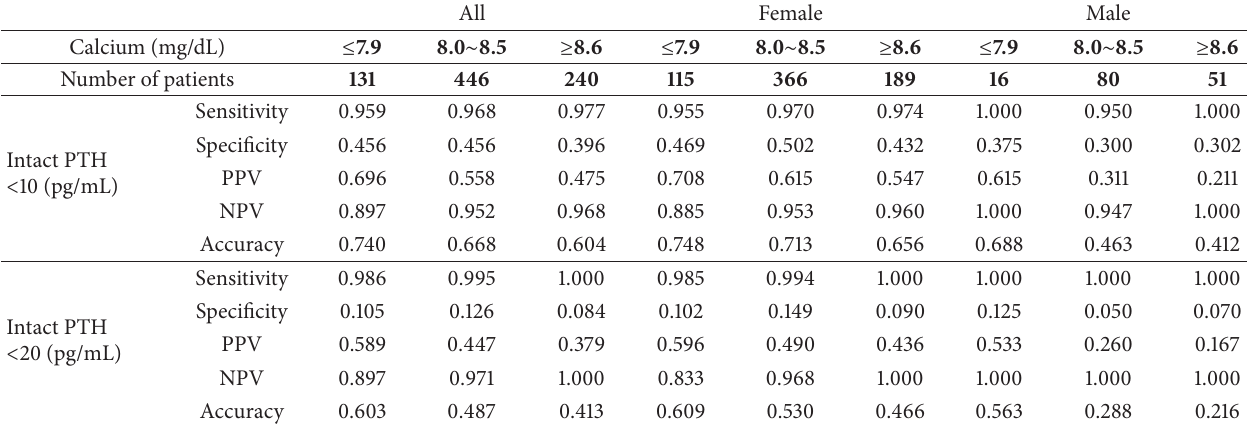
Table 3: Predictabilities of intact PTH cut-offs according to serum calcium